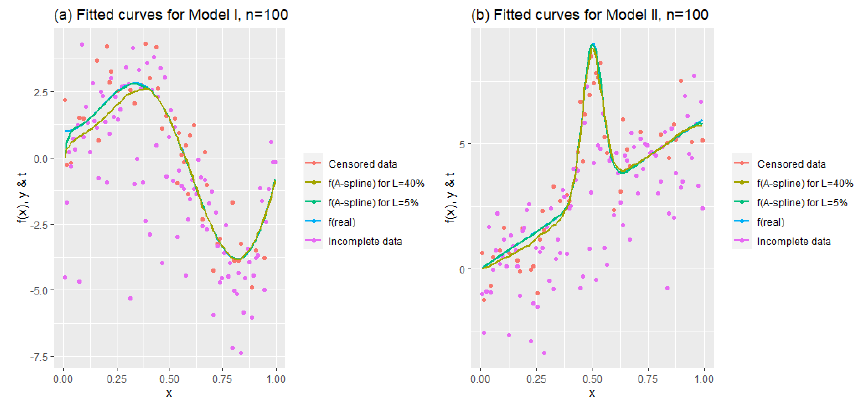
Figure 4. Fitted curves to observe the quality of the estimates for n = 100, L = 5%, 40%.